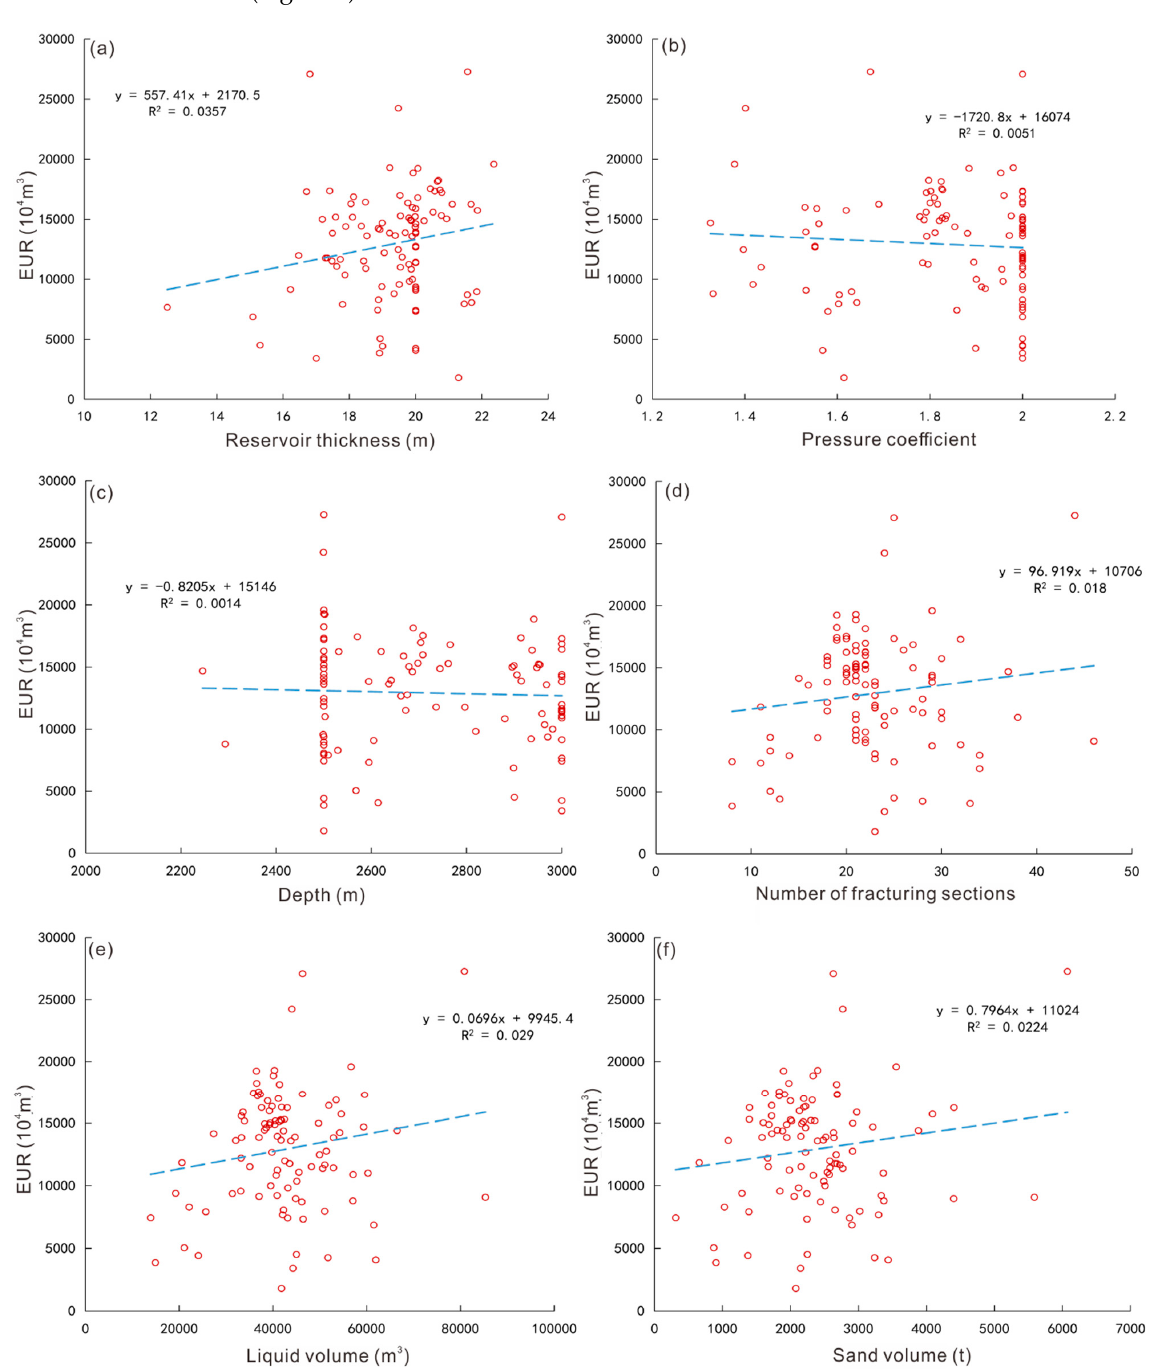
Figure 1. Statistical relationships between parameters and EUR of a well in the production block. ( a ) Relationship between EUR and reservoir thickness; ( b ) relationship between EUR and pressure coefficient; ( c ) relationship between EUR and depth; ( d ) relationship between EUR and number of fracturing sections; ( e ) relationship between EUR and liquid volume; ( f ) relationship between EUR and sand volume.